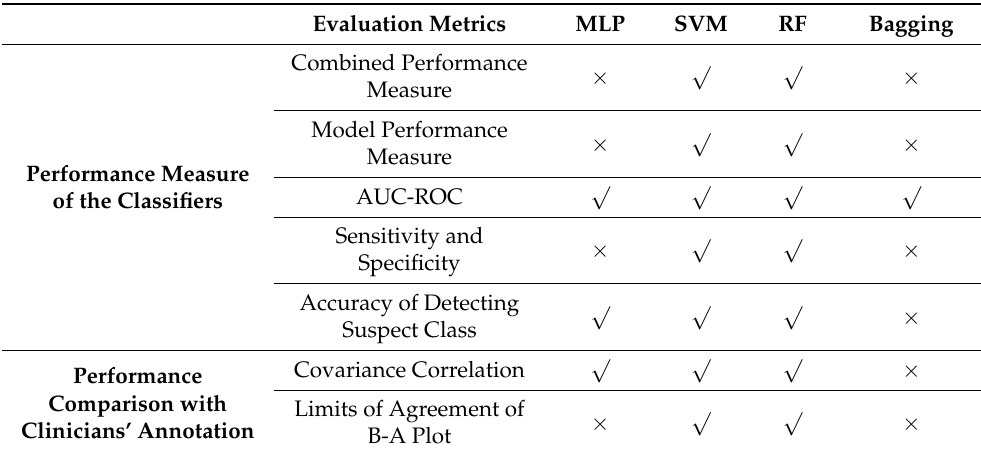
Table 12. Performance measure of the classifiers in terms of various statistical evaluation metrics and classification performance in comparison with the clinicians’